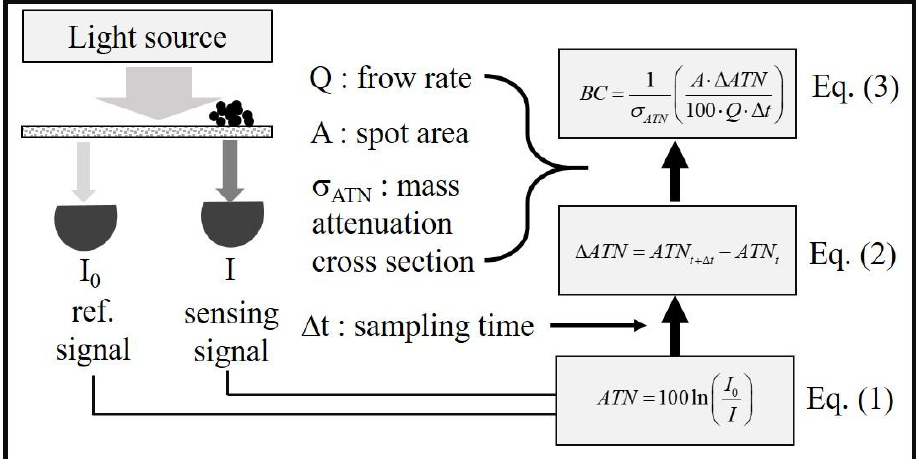
Figure 1. Schematic diagram of microAeth ® AE51 and flow chart of the procedure for calculating black carbon (BC) concentration from signals.